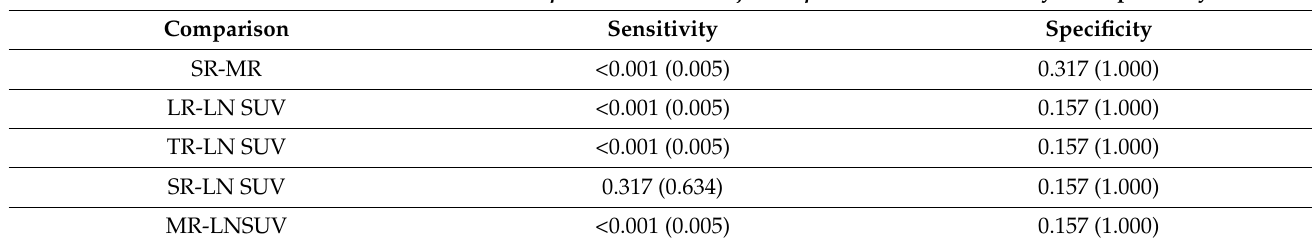
Table 5. Cont. p -Values (with Adjusted p -Values) for Sensitivity and